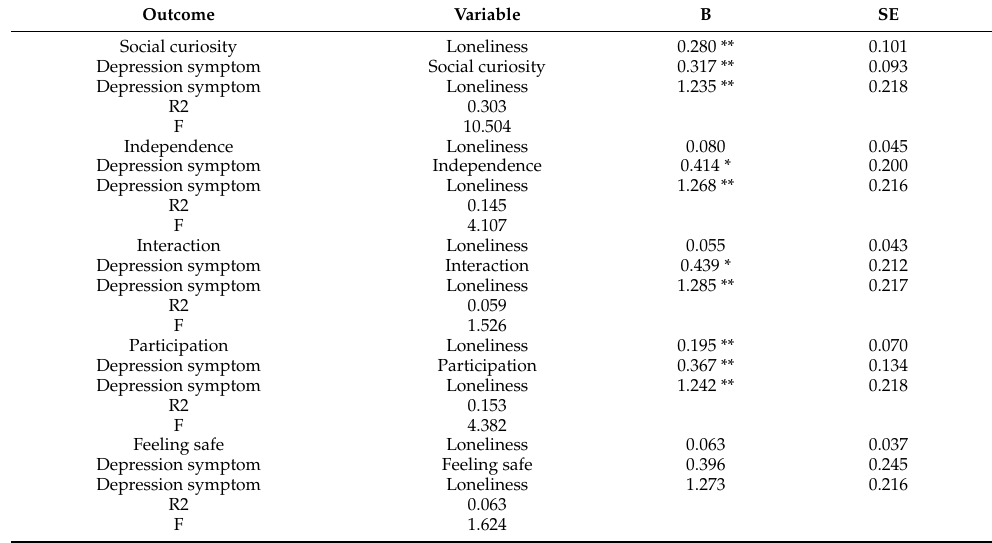
Table 3. Mediation